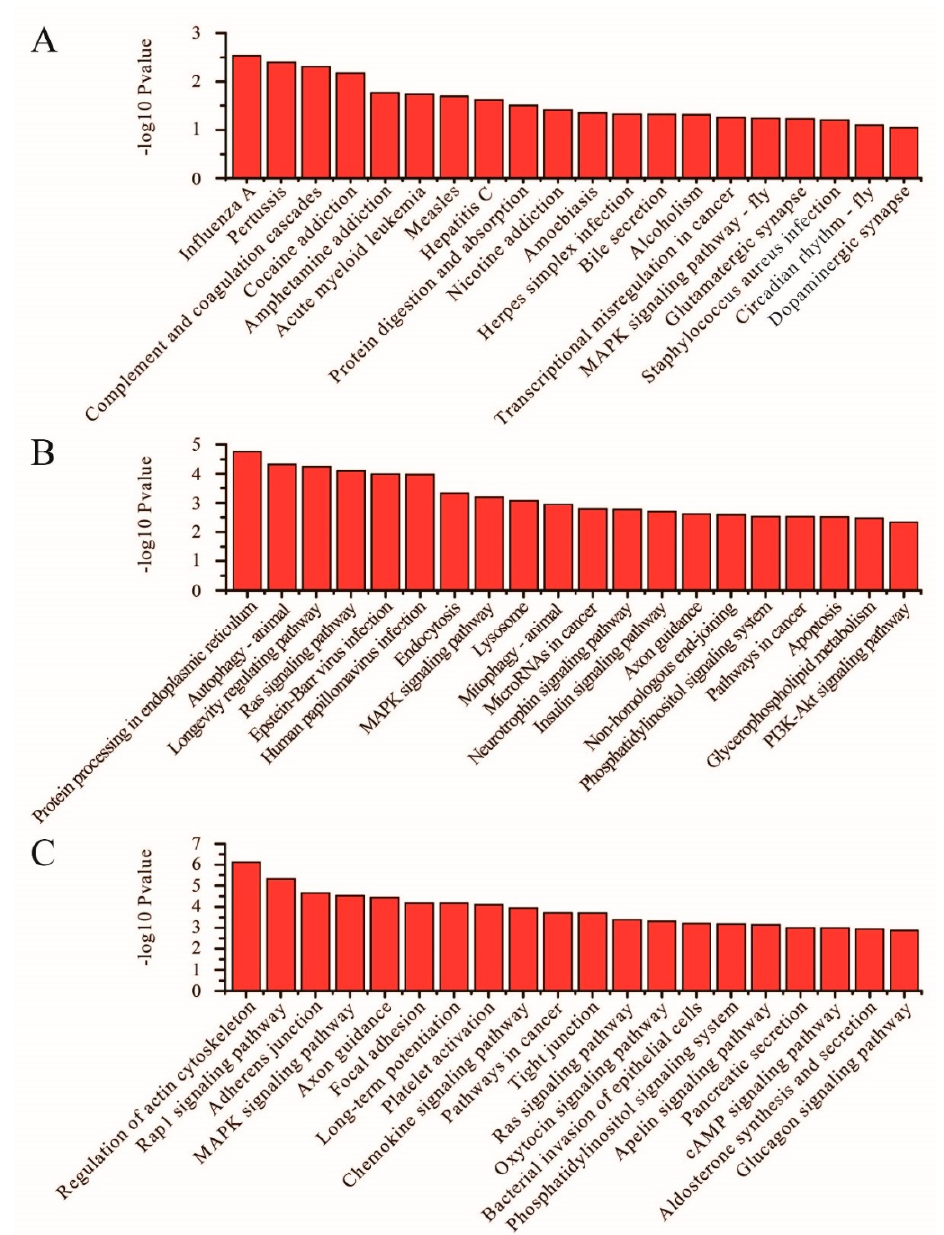
Figure 4. KEGG analyses of differentially expressed genes between the SP and SLP groups. ( A ) The top 20 KEGG enrichment pathways for differentially expressed mRNAs between the SP and SLP groups. ( B ) The top 20 KEGG enrichment pathways for differentially expressed lncRNA target genes between the SP and SLP groups. ( C ) The top 20 KEGG enrichment pathways for differentially expressed circRNA host genes between the SP and SLP groups.